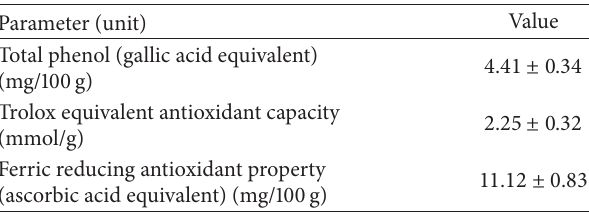
Figure 2: NO radical scavenging ability of essential oils from black pepper. Values represent means ± standard deviation of triplicate readings. Table 1: The total phenolic content reported as gallic acid equiv- alent, trolox equivalent antioxidant capacity and ferric reducing antioxidant property reported as ascorbic acid equivalent of essen- tial oils from black